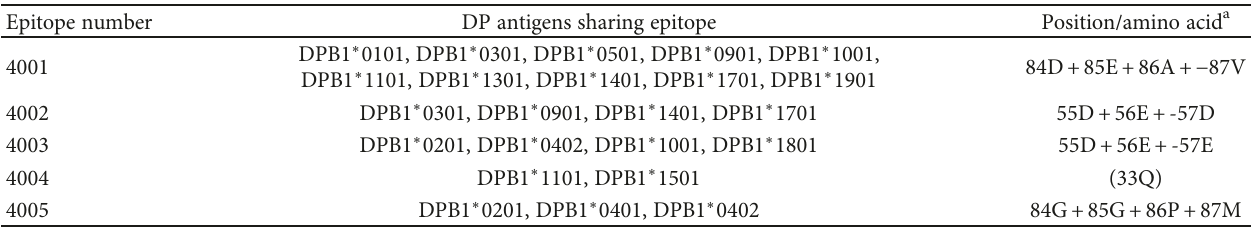
Table 9: HLA class II DP